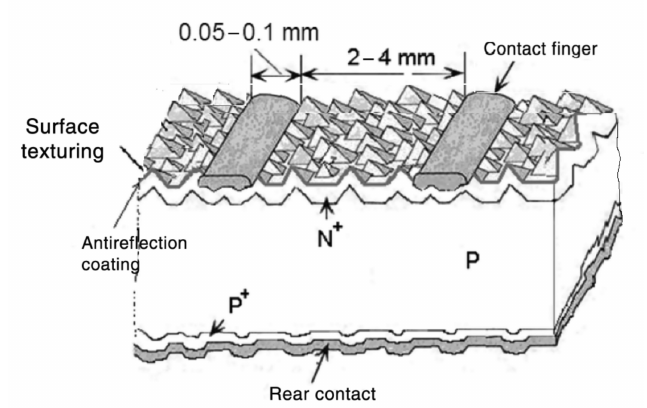
Figure 8. BSF cell